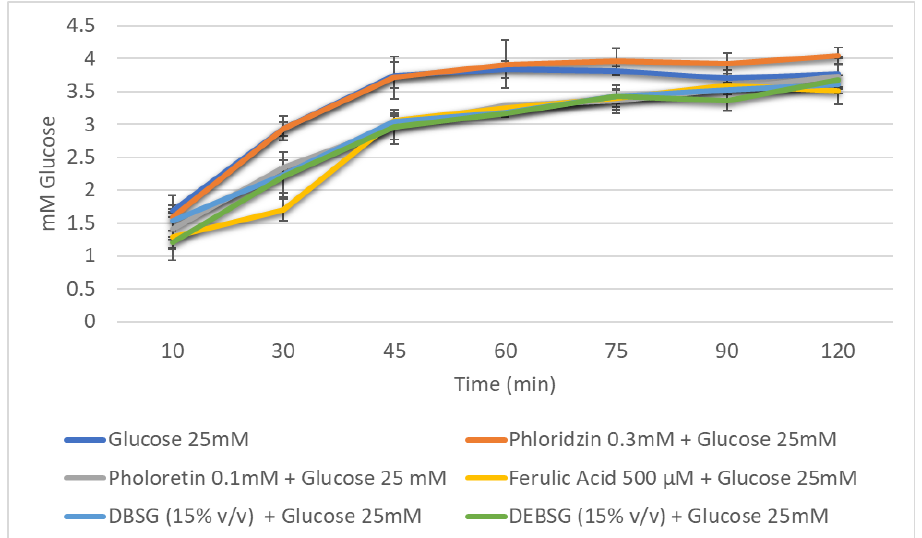
Figure 5. Glucose absorption in IEC-6 cells over time against reference inhibitors of glucose trans- porters (phloridzin and phloretin), ferulic acid, brewers’ spent grain intestinal digest (DBSG) and extruded brewers’ spent grain intestinal digest (DEBSG) under sodium-free conditions. Table 9. Incremental area under the curve for glucose absorption inhibition models.